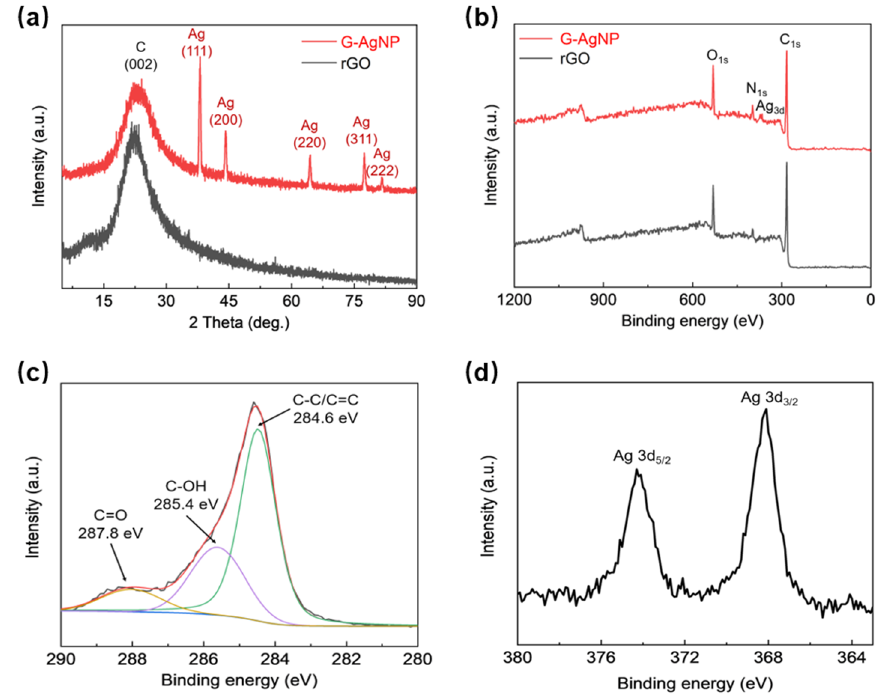
Figure 3. ( a ) XRD investigation. ( b – d ) XPS spectra for all elements, C1s and Ag 3d.